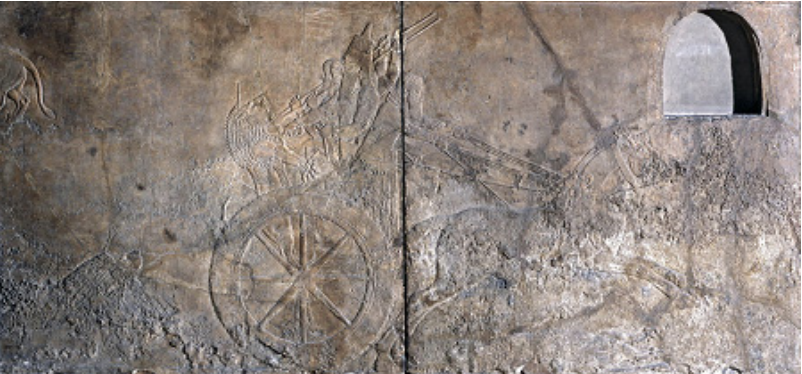
Figure 2. King Ashurnasirpal II hunting lions (BM inv. no. 124534; reg. no. 1847,0623.11); relief scene, gypsum; NW Palace, Nimrud (mod. Iraq); Neo-Assyrian, ca. 865–860 BCE [image courtesy of the Trustees of the British Museum, London].